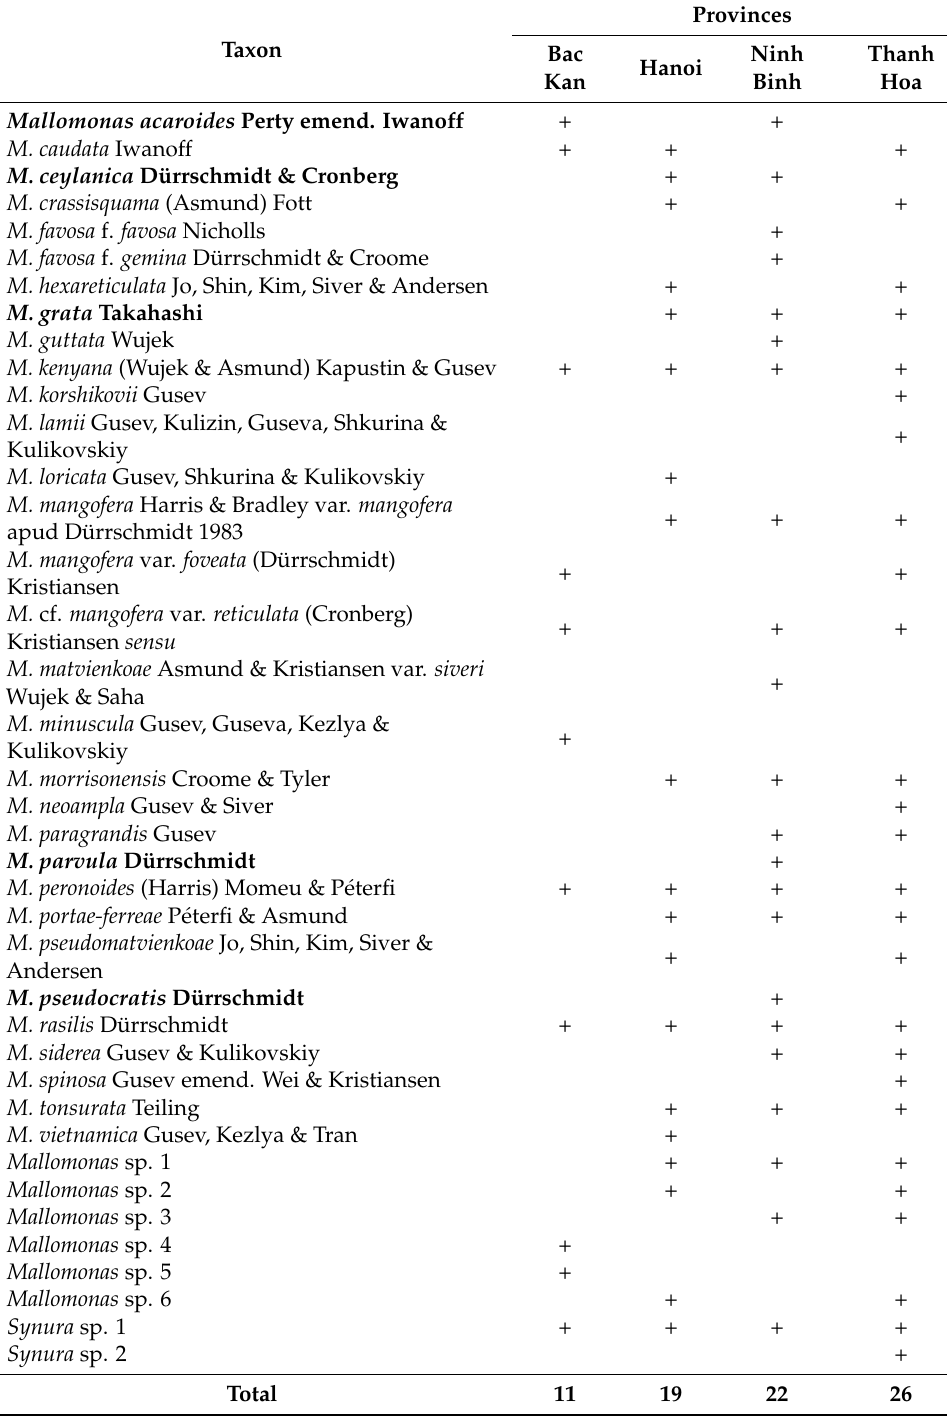
Table 1. List of taxa from the order Synurales found in four provinces of Northern Vietnam. New taxa for Vietnam are given in bold, “+” indicates the presence of taxon. Taxon Mallomonas acaroides Perty emend. Iwanoff + +